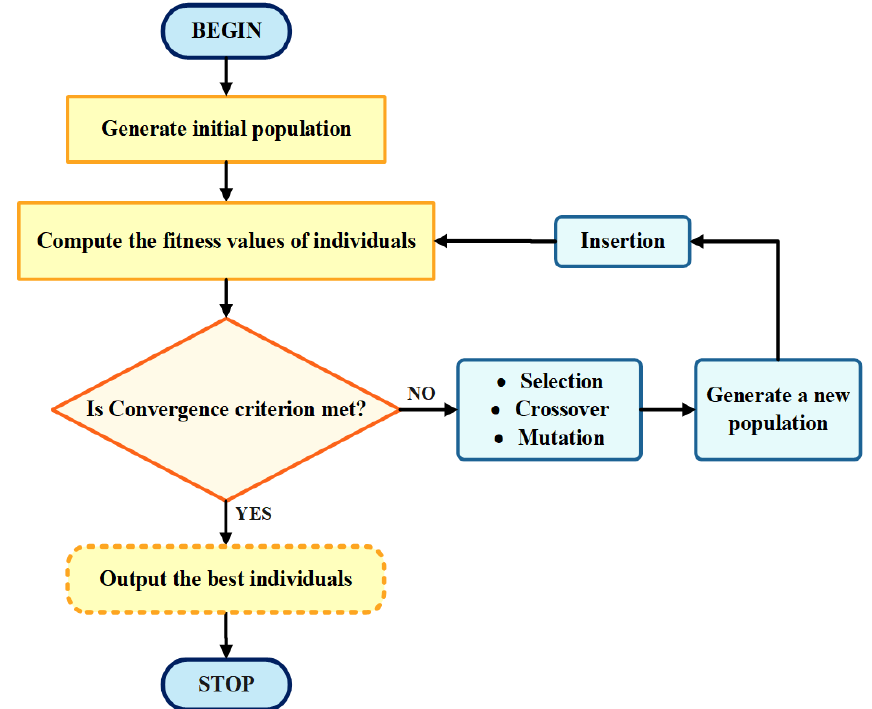
Figure 1. Flowchart depicting the GA algorithm strategy Initially, a population is randomly generated, and the evolution process occurs in each iteration. The population per the iteration count is known as a generation. The objective function is computed for each generation, and later, the best solution is chosen from the current population. Then, the selected individuals are modified to produce a new generation. This iterative process is continued until the optimum solution is achieved for the population. The two main constituents of the GA are: 1. Solution domain representation in genetic